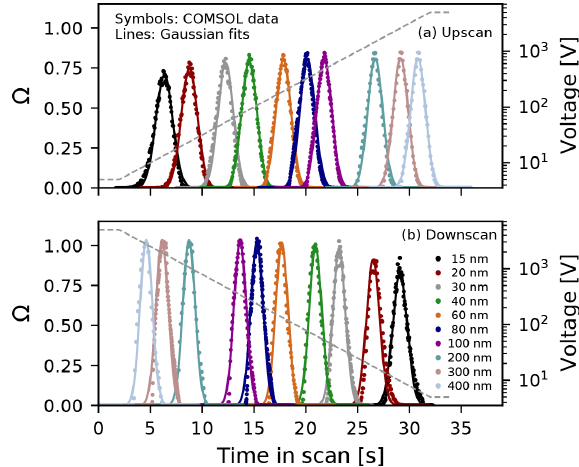
Figure 2. Finite-element modeling of the Spider DMA scan- ning transfer function for (a) upscan and (b) downscan expo- nential voltage ramps with 30s duration and 0.9Lmin − 1 sheath and 0.3Lmin − 1 aerosol flow rates. Symbols correspond to finite- element modeling data (ratio of particle number at the outlet to the inlet), solid lines show Gaussian distributions fitted to the model- ing data, and dashed lines indicate the scanning voltage program (values shown on right y